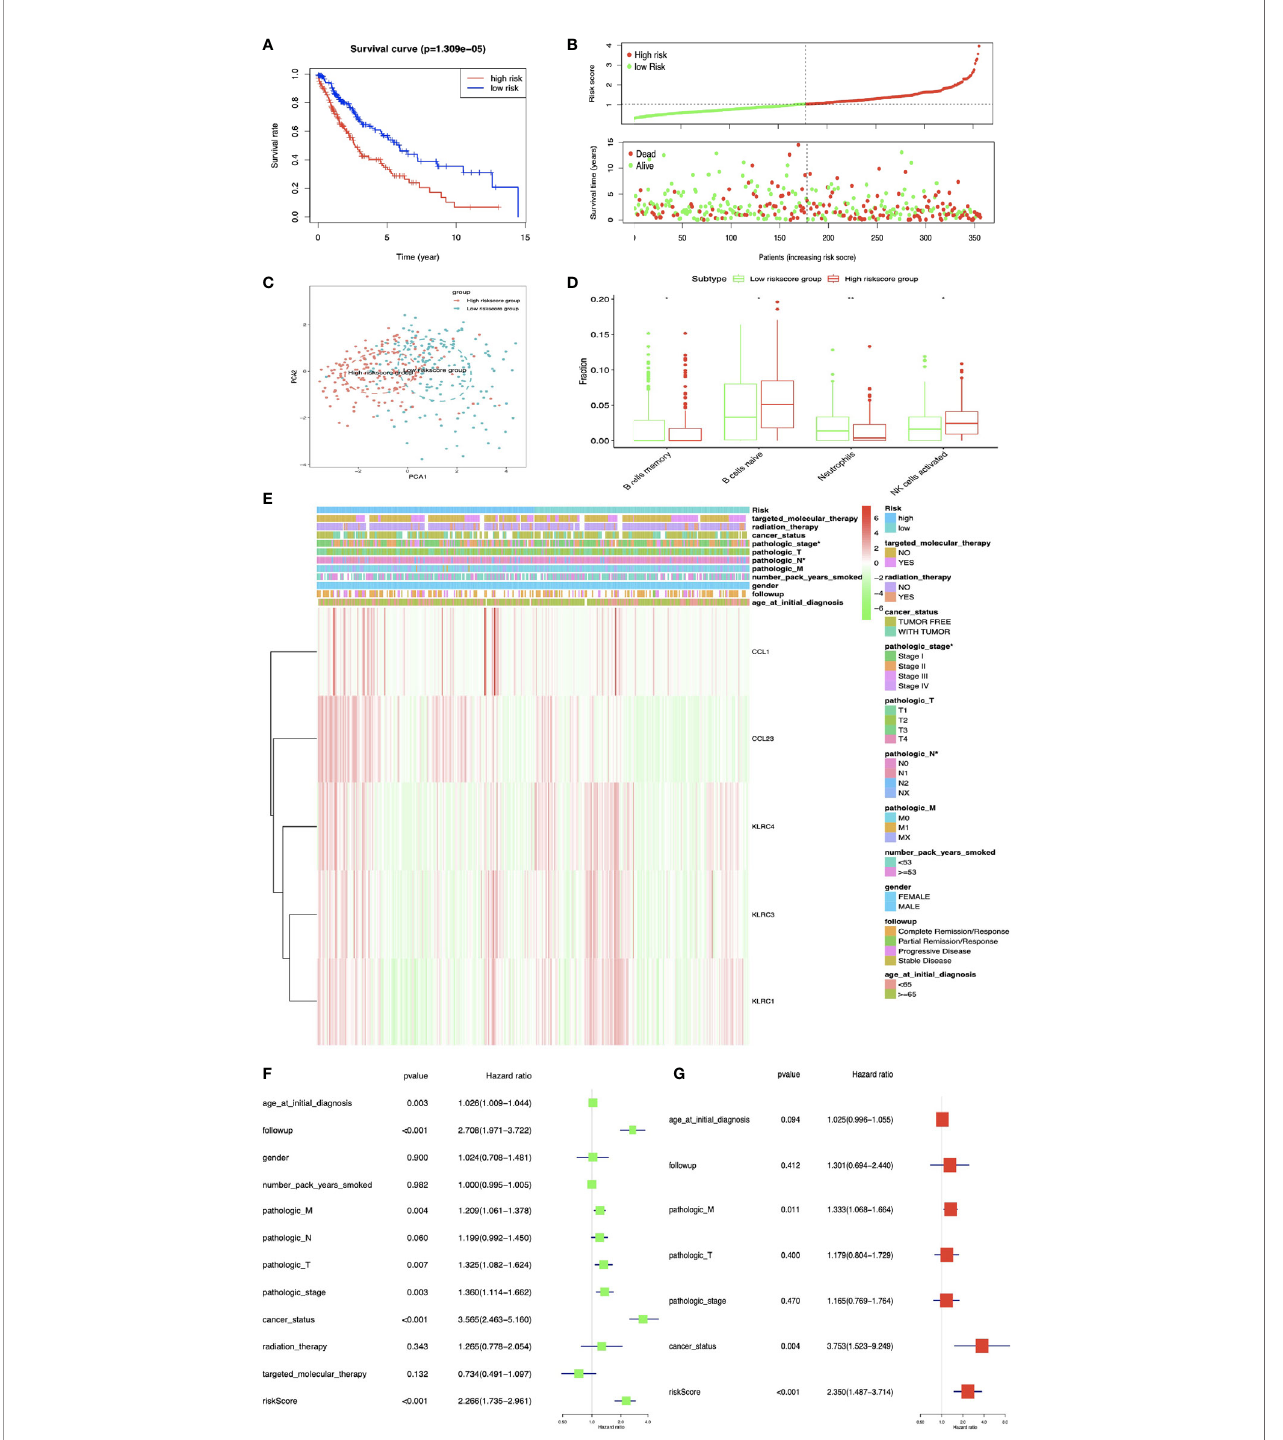
FIGURE 8 | The multiple linear regression identi fi ed the prognostic model in LUSC. (A) OS analysis between high- and low-risk score groups. (B) Risk plot between high- and low-risk score groups. (C) Principal component analysis (PCA) for the risk scores. Blue means low-risk score samples; red means high-risk score samples. (D) Boxplot showed the ratio differences of four immune cells between high- and low-risk score groups in LUSC, and Wilcoxon rank sum was used for the signi fi cance test. (E) The heatmap ofclinical correlation between high- and low-risk score groups in LUAD. (F) The univariate Cox regression analysisof risk factors inLUSC. (G) The multivariate Cox regression analysisofriskfactorsin LUSC. *p < 0.05, **p <